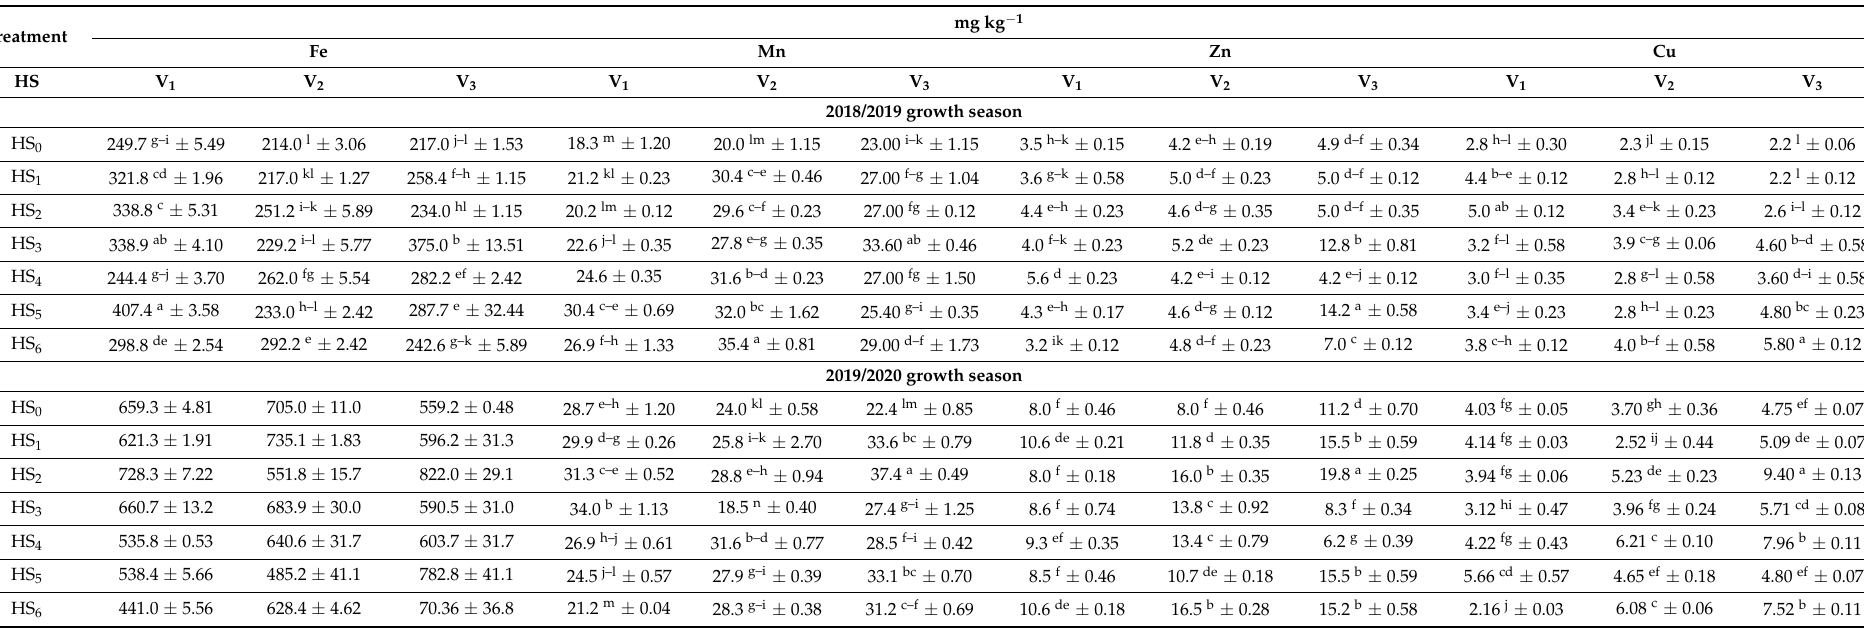
Table 9. Influence of humic substances doses on some leaf iron, manganese, zinc, and copper contents of some wheat varieties grown in clay soil in 2018/2019 and 2019/2020